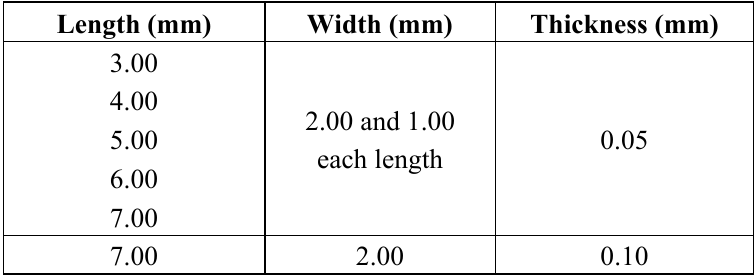
Figure 3. Experimental setup for investigation of the influence on the proximate oscillator during excitation of the desired oscillator by varying the distance d ( b ) Top view of the experimental setup exemplarily shown for the distance d with the excitation of the oscillator on the left hand